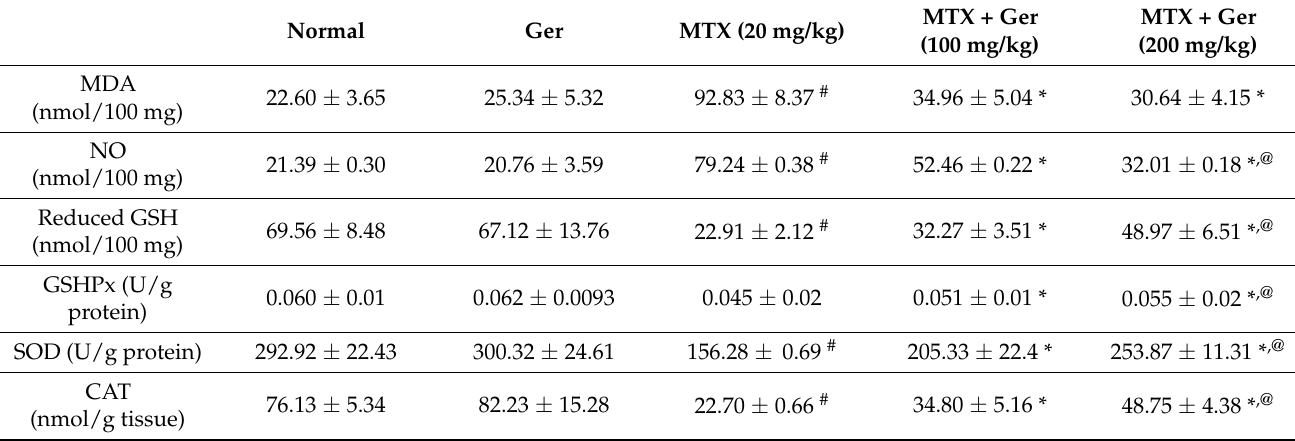
Table 3. Effects of treatment with geraniol on antioxidants activities in MTX-induced AKI in rats.